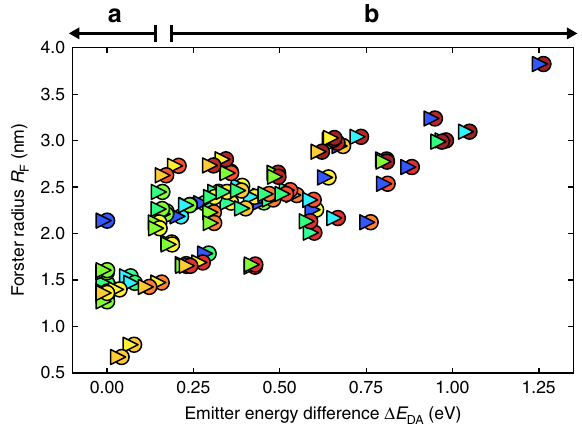
Fig. 4 Calculated Förster radii versus energy difference for the 84 donor – acceptor combinations. Every point in the graph represents a transfer process from a donor (triangle) to an acceptor (circle), with emission colors as indicated. The Δ E D A -regions indicated in the top part of the fi gure (a) and (b) indicate the mechanism (see Fig. 1) by which the exothermicity enhances R F